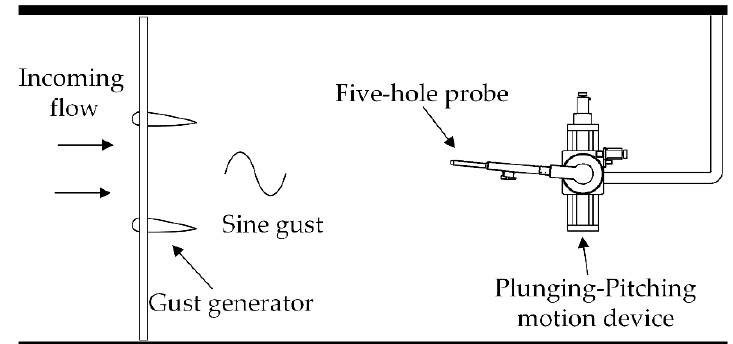
Figure 3. Wind tunnel test schematic for gust calculation.